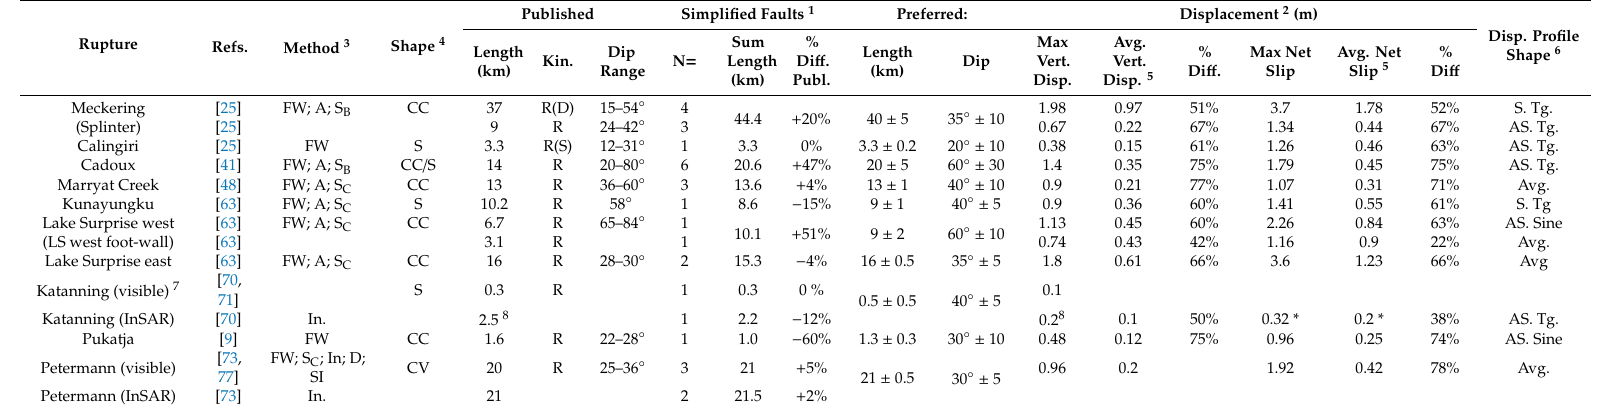
Table 6. Summary of surface measurements for each